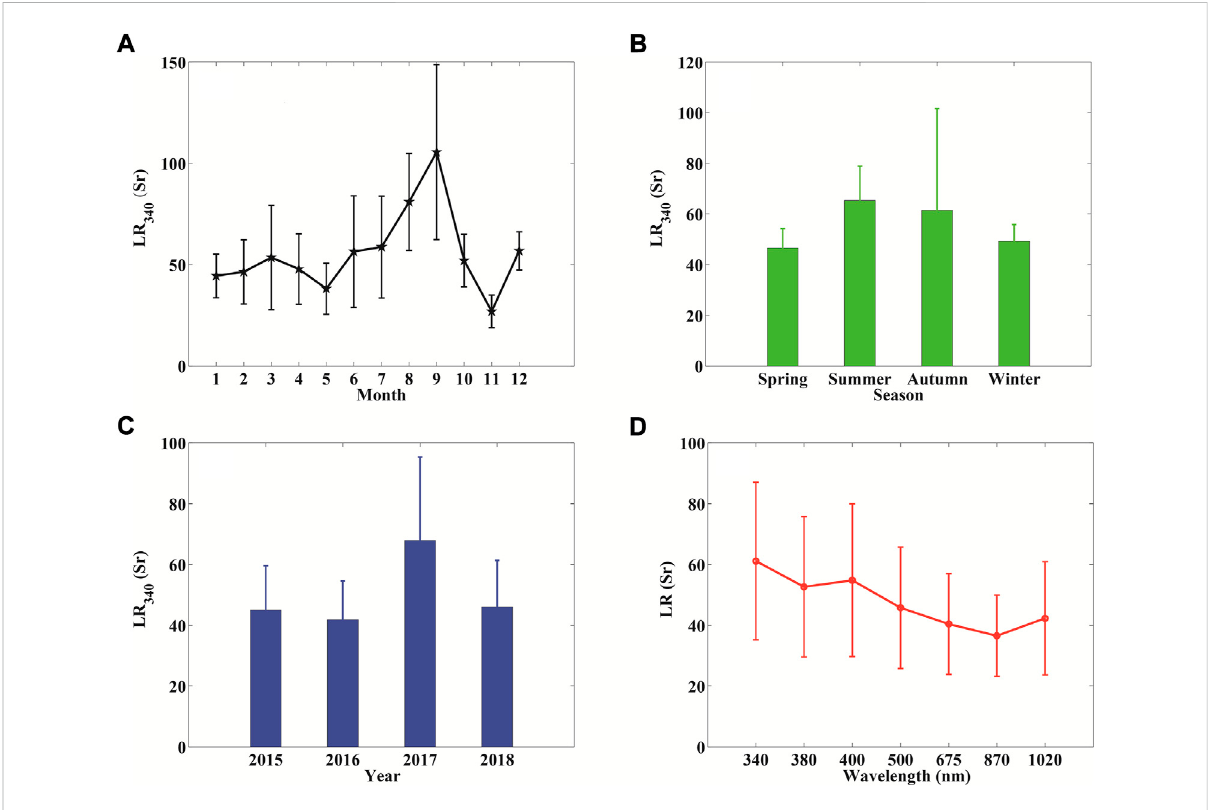
FIGURE 11 Monthly (A) , seasonally (B) , yearly mean (C) and spectral variations of lidar ratios (D)